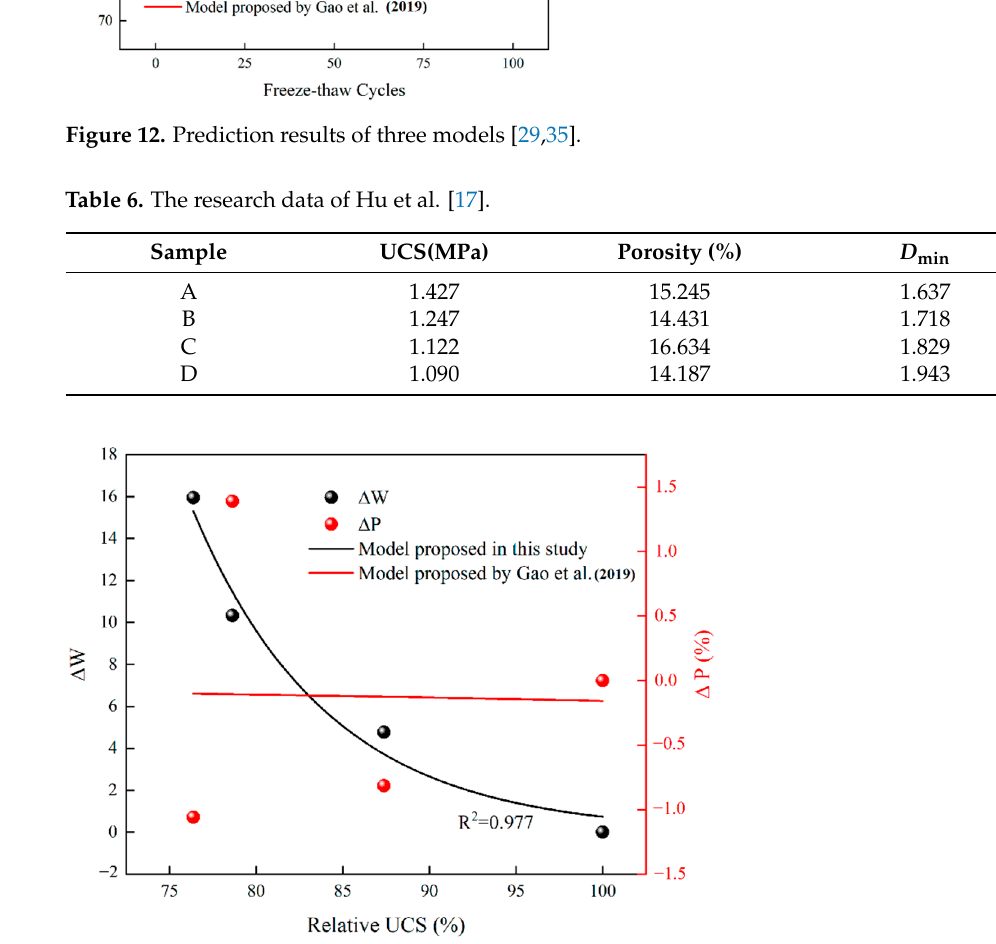
Figure 12. Prediction results of three models [29,35].